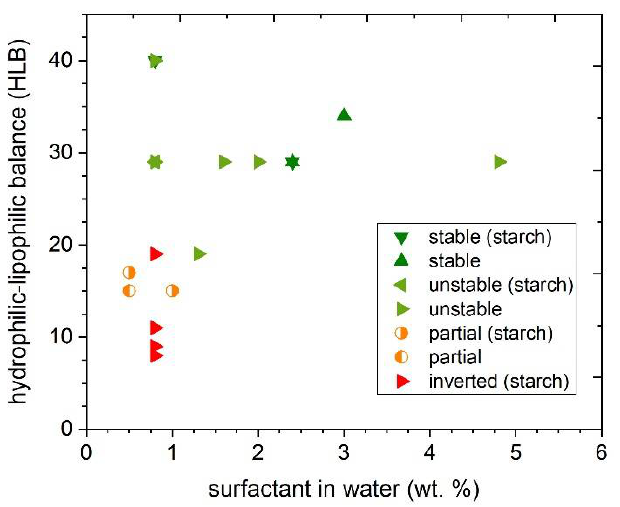
Figure 3. Influence of hydrophilic–lipophilic balance (HLB) and concentration of surfactant in water on the formation and stability of the formulations.